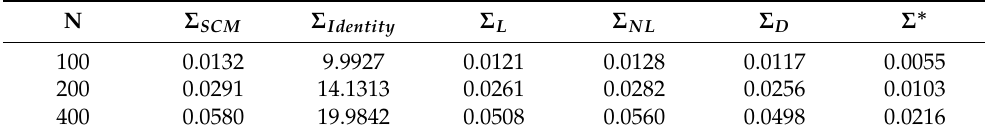
Table 4. The error between each estimator and the population covariance matrix under the optimal parameter.